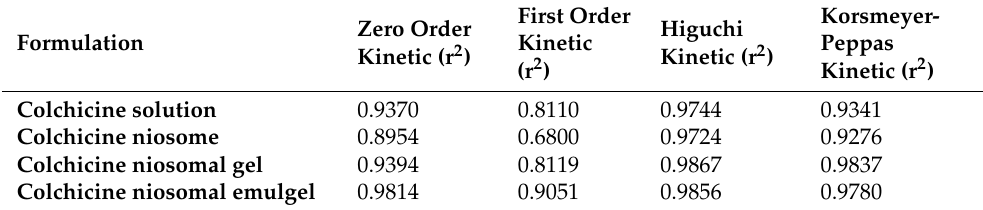
Table 5. Release kinetics of various colchicine niosomal formulations.